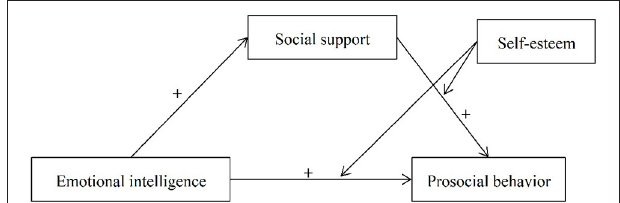
FIGURE 1 | The moderated mediation effect among emotional intelligence, prosocial behavior, social support, and self-esteem. The + sign denotes a positive relationship for a